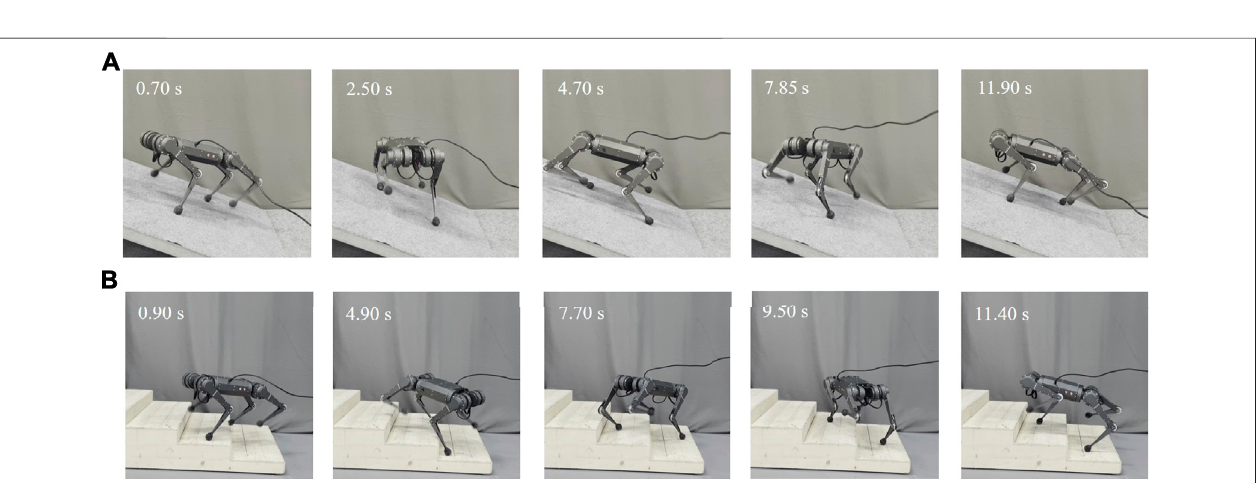
Frontiers in Robotics and AI |